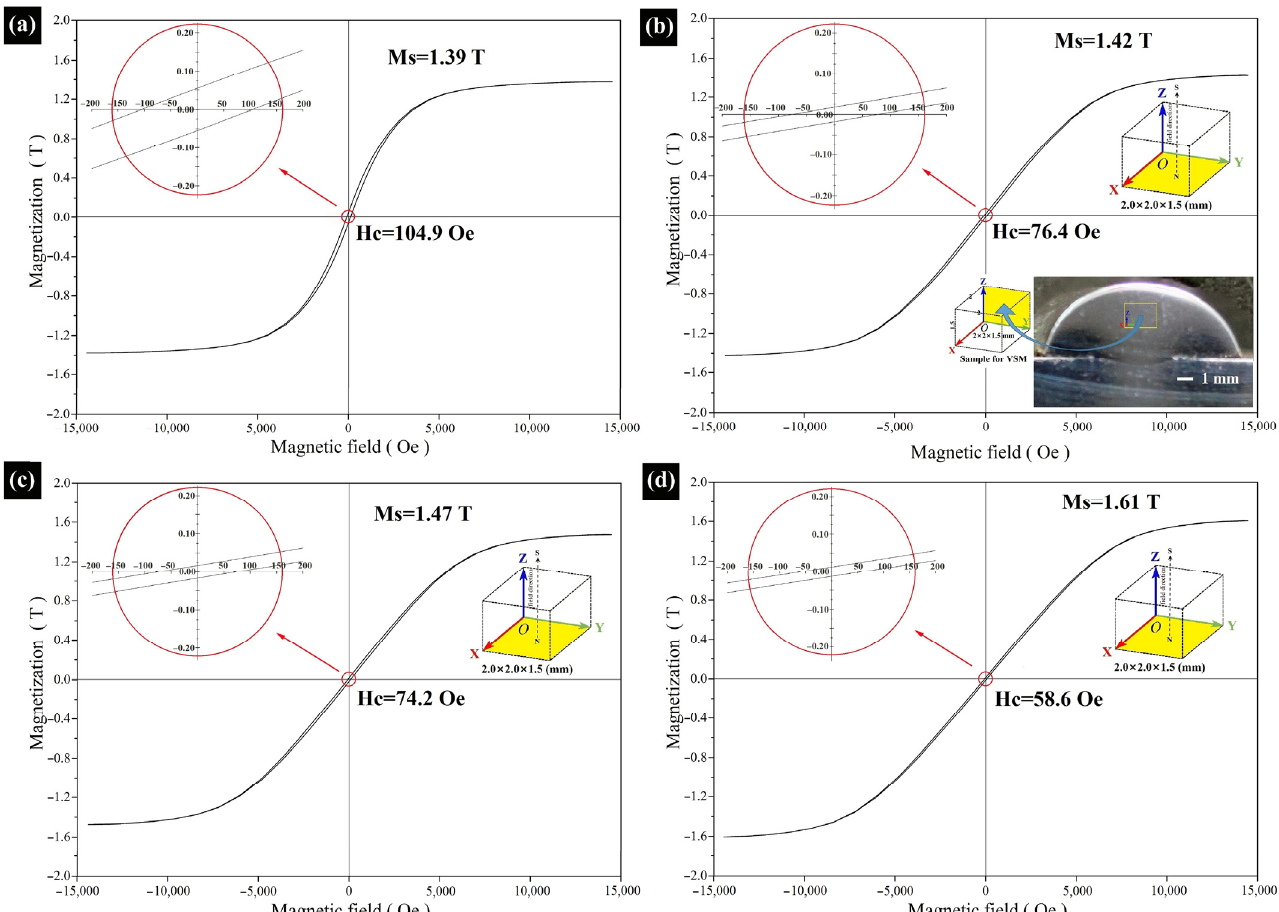
Figure 10. Hysteresis loops of ( a ) the feedstock powders Fe313 and the PTA-welded coating ( b ) C1, ( c ) C2 and ( d ) C3 sorted by increasing saturation magnetization Ms.